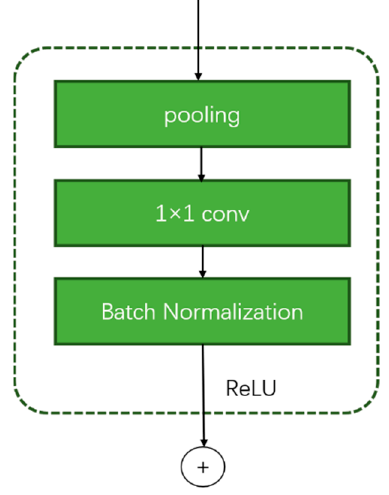
Figure 6. Feature enhancement module.